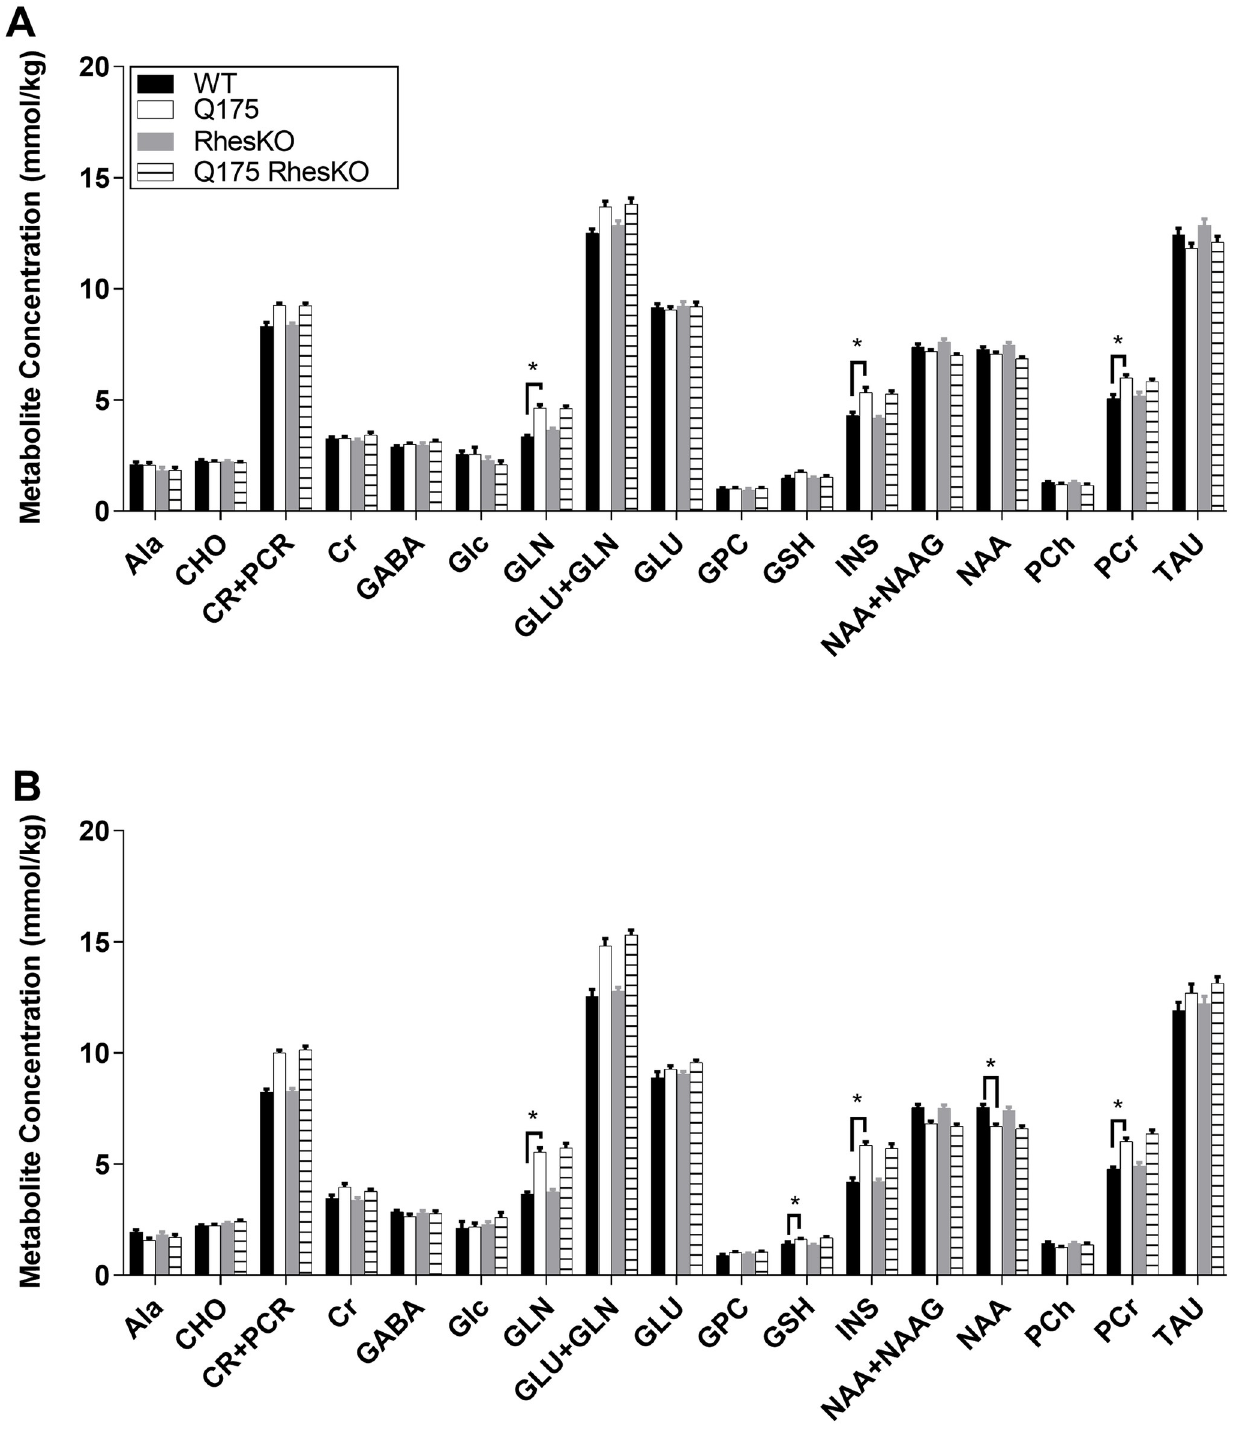
Fig 5. MR Spectroscopy analysis of Q175/Rhes female mice, (A) at 6 months of age and (B) at 12 months of age, presenting measured striatal metabolite concentrations from: Ala, alanine; CHO, choline; CR+PCR, creatine+phosphocreatine; CR, creatine; GABA, gamma-aminobutyric acid; Glc, glucose; GLN, glutamine; GLU+GLN, glutamate+glutamine; GLU, glutamate; GPC, glycerophosphocholine; GSH, glutathione; INS, myo-inositol; NAA+NAAG, N- acetylaspartate+N-acetylaspartylglutamate; NAA, N-acetylaspartate; PCh, phosphocholine; PCr, phosphocreatine; TAU, taurine;. Data are presented as mean, + SEM (WT n = 9; RhesKO n = 11; Q175 n = 9; Q175;RhesKO n = 9); Two-way mixed ANODE followed by Tukey’s test, � p < 0.05.